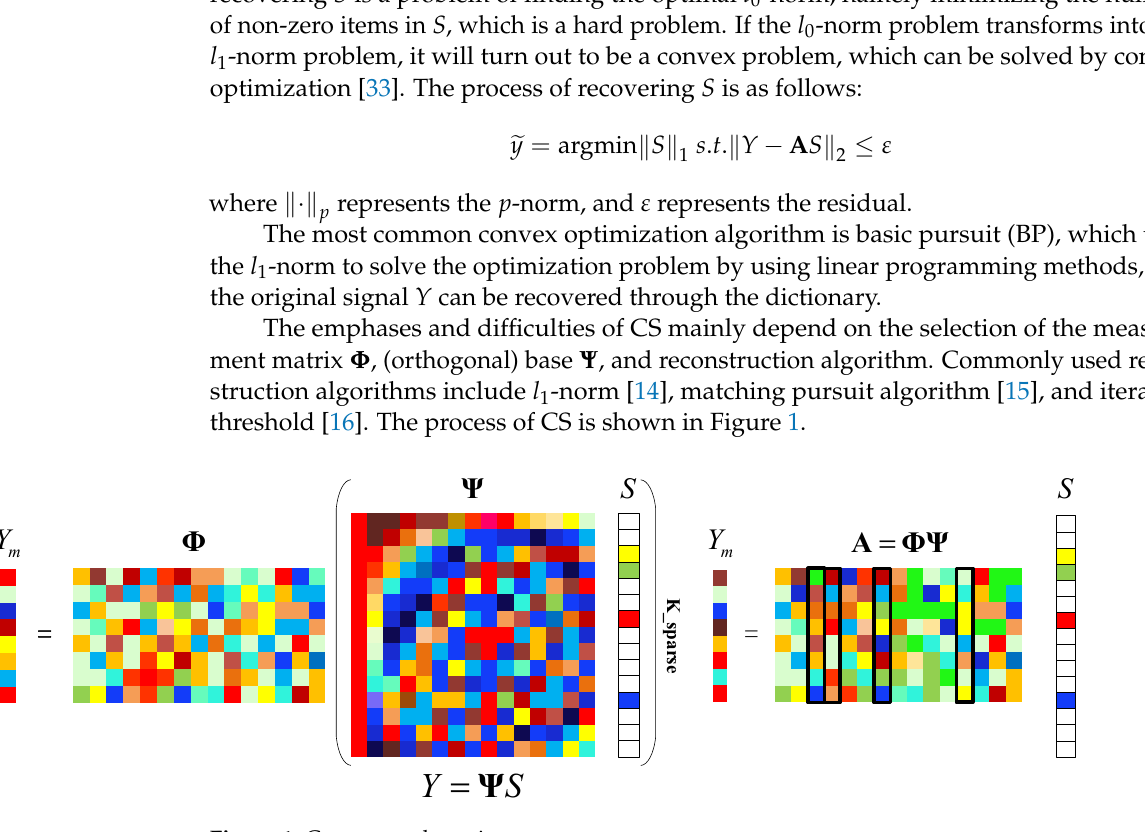
Figure 1. Compressed sensing process.